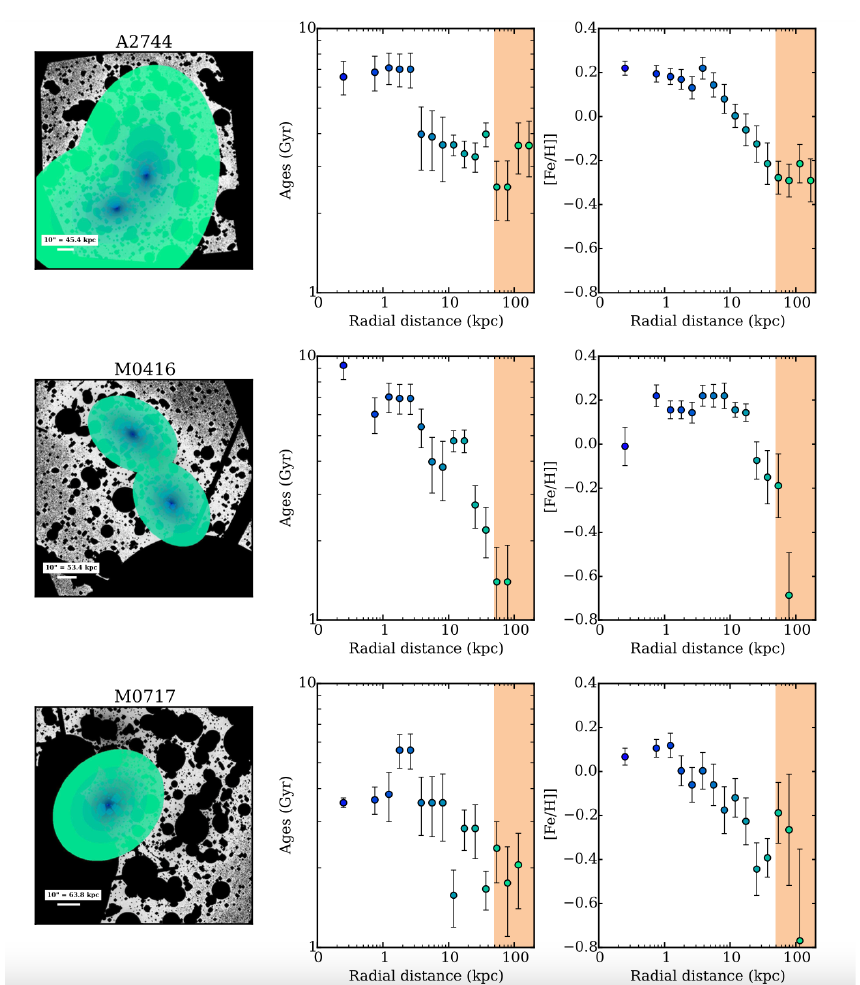
Figure 10. A few examples of age and metallicity gradients for three clusters of the Hubble Frontiers field survey in the range 0.3 < z < 0.6. The clear tendency for the stellar populations in these BCG + ICL systems is to become younger and more metal-poor with increasing distance from the center, i.e., in the regions dominated by the ICL. Metallicity and age are derived via stellar population synthesis models (see the original paper for the details of the modeling). Credit: Montes; Trujillo